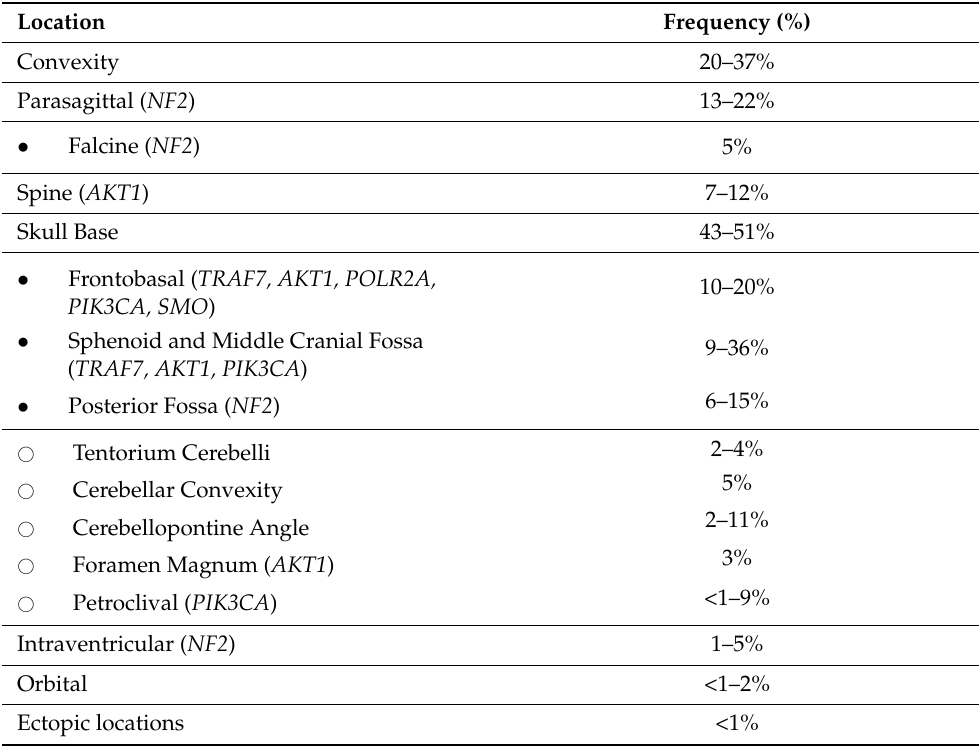
Table 4. Meningioma locations with associated